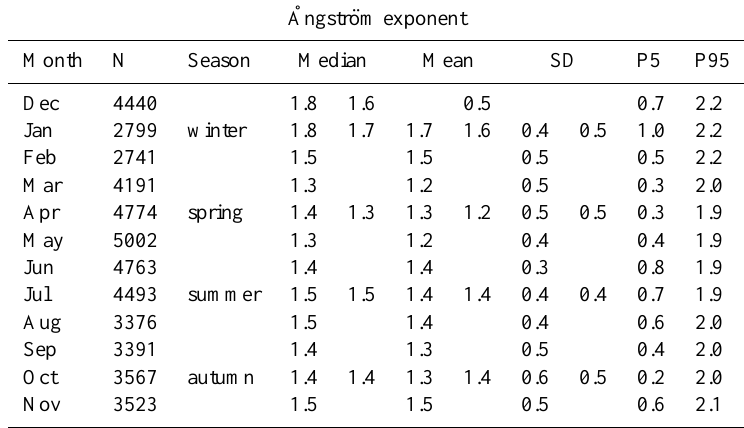
Table 5b. Basic statistical properties of α organized for each month and season between 2002 and 2008.